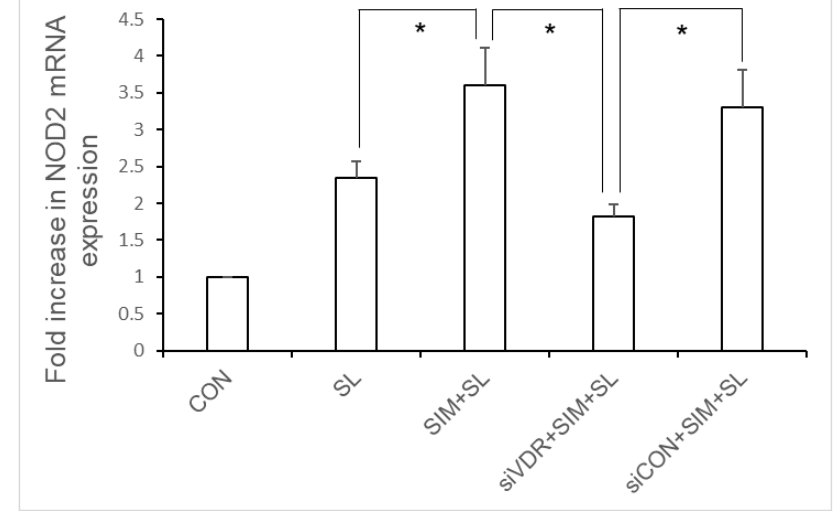
Figure 5. Involvement of vitamin D receptor (VDR) in simvastatin-mediated enhanced NOD2 mRNA expression in Salmonella -infected SW480 cells. SW480 cells were transfected with control siRNA or VDR siRNA (siCON = non-target control siRNA; siVDR = siRNA against VDR) for 48 h. Transfected SW480 cells were untreated or pre-treated with 10 μM simvastatin (SIM) prior to wild-type S. Typhimurium strain SL1344 infection (SL) for one hour. Total RNA was prepared after the infection and analyzed by real-time quantitative PCR to estimate the levels of NOD2 mRNA. The amount of NOD2 mRNA produced, normalized to the corresponding amount of GAPDH mRNA, is shown as the fold increase over uninfected control (CON) cells. The results indicate the means and standard deviations for duplicate wells from at least three separate experiments (* p < 0.05).